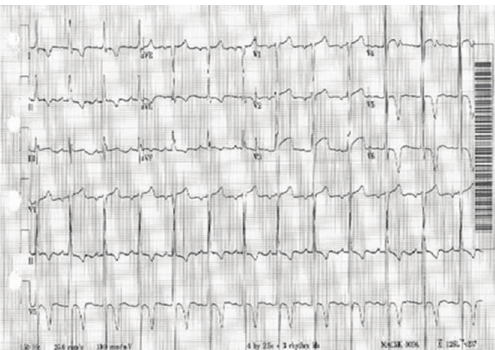
Figure 1: Electrocardiogram showing left ventricle hypertrophy and repolarization abnormality but no acute ST-T changes sugges- tive of myocardial